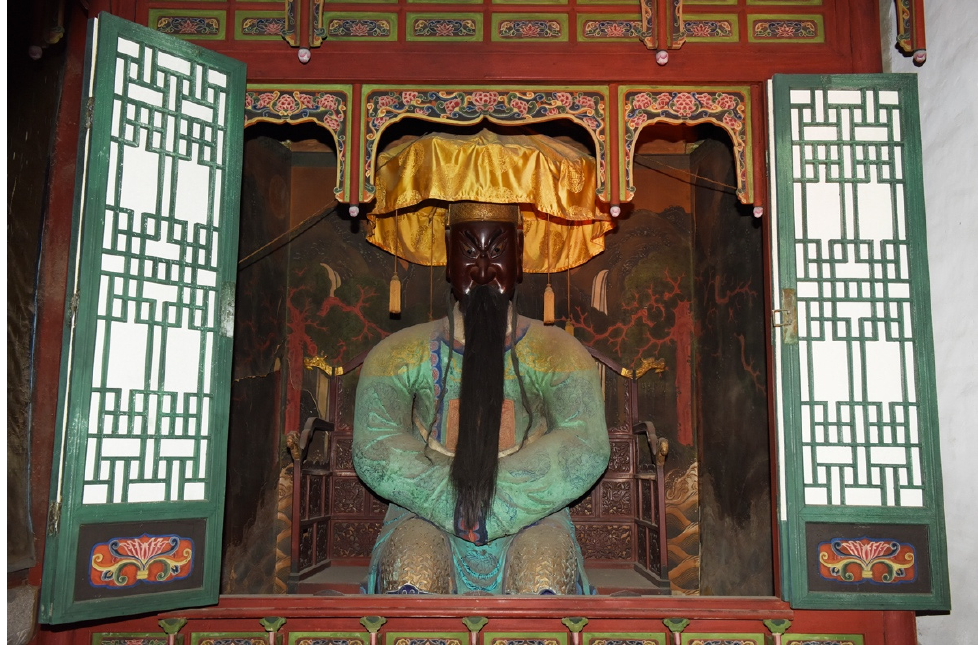
Figure 3. Kwanje in dragon robe , formerly main icon of the Northern Shrine, 1883. Red lacquer on wood (head) and molded clay (body). H 216 cm. Main Hall of Eastern Shrine, Seoul. Image licensed under Creative Commons, reproduced with permission from the Korean Cultural Heritage Admin- istration, Taej ŏ n.